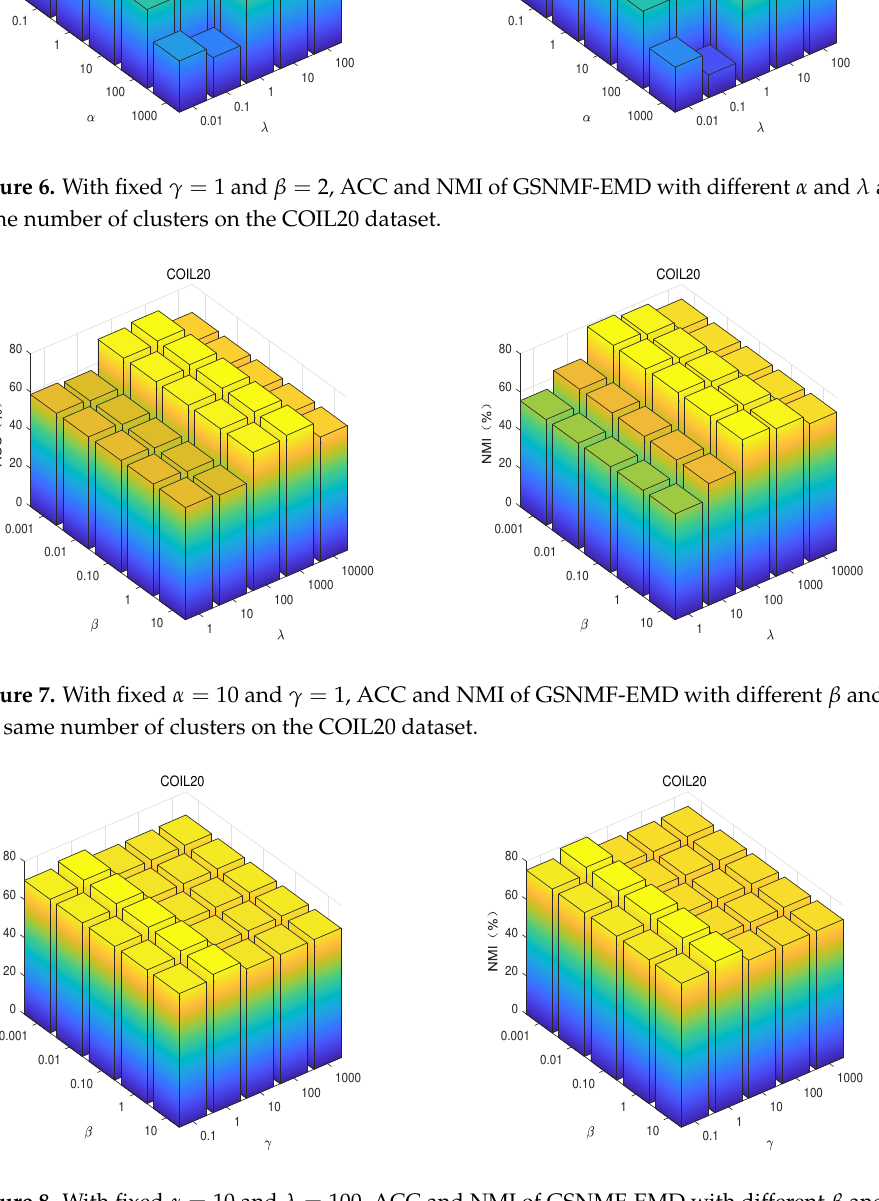
Figure 8. With fixed α = 10 and λ = 100, ACC and NMI of GSNMF-EMD with different β and γ and the same number of clusters on the COIL20